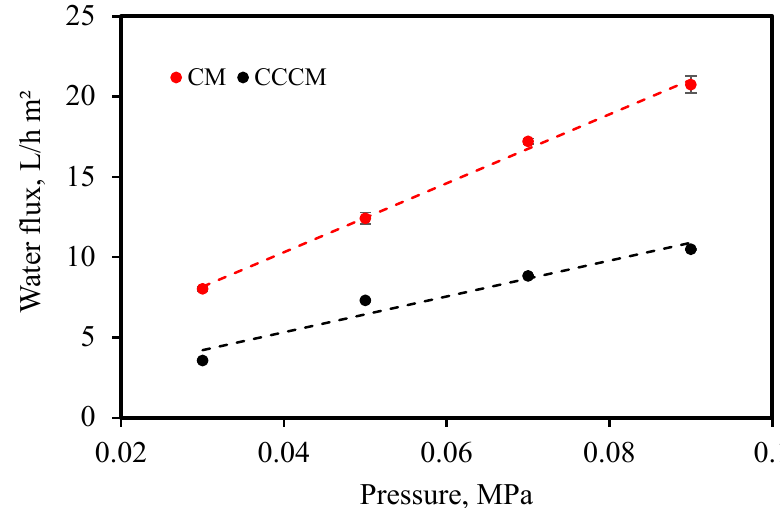
Figure 9. Effect of pressure on the water flux by CM and CCCM.